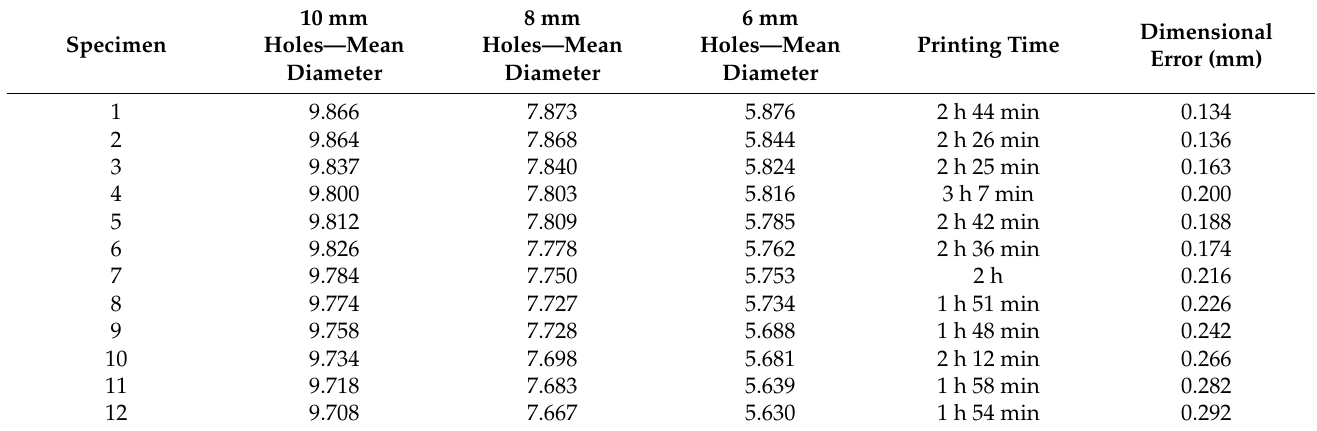
Table 4. Results of the experiment 1: diameters’ mean values and printing